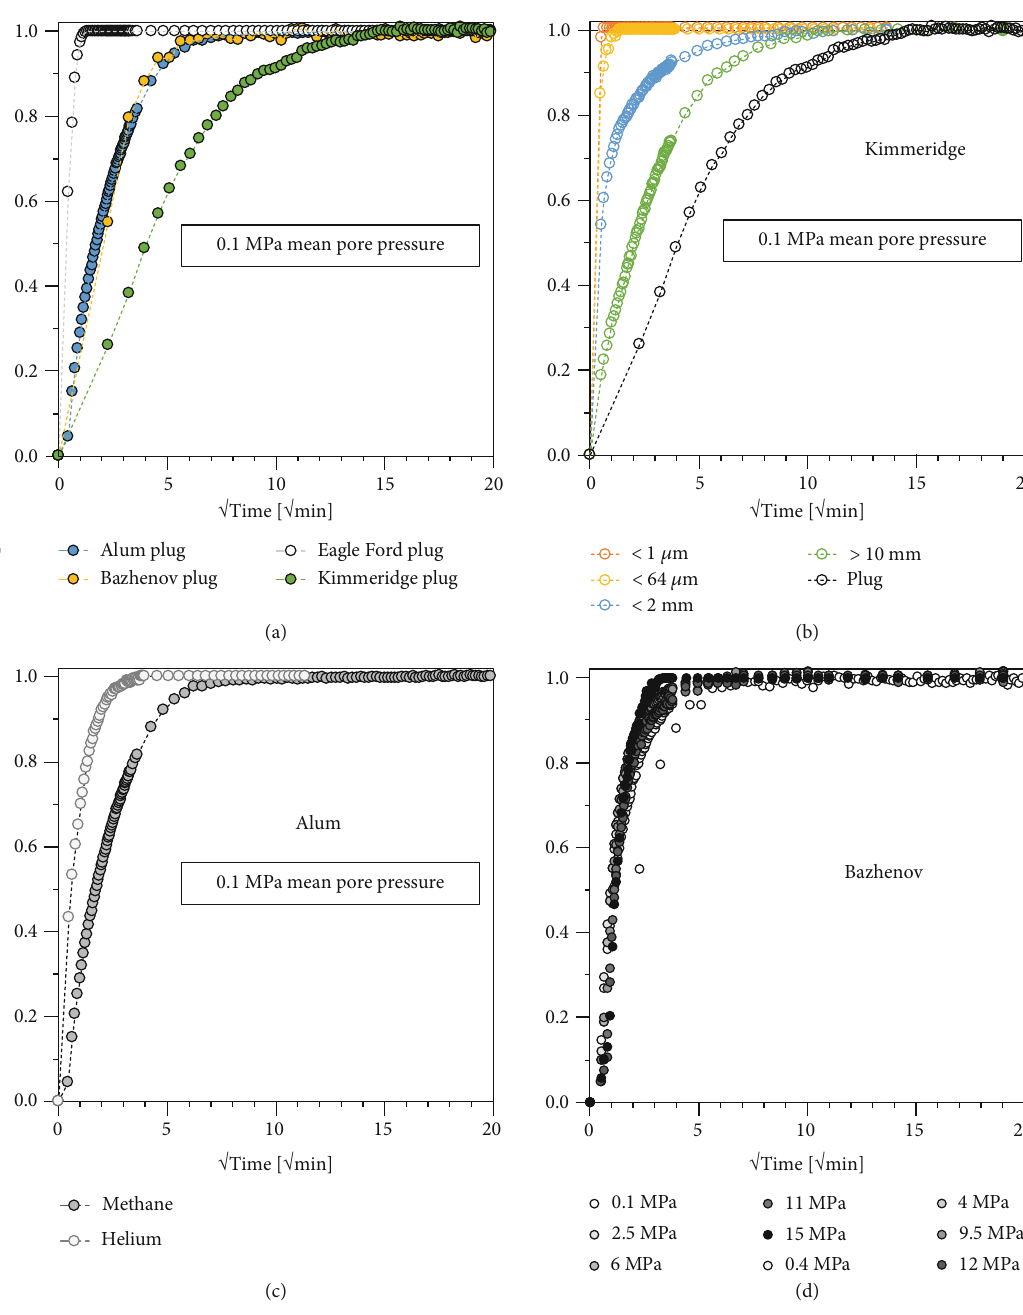
Figure 6: (a) Comparison of fractional methane uptake for all samples investigated in this study at constant mean pore pressure, (b) fractional methane uptake for Kimmeridge Clay at constant mean pore pressure and varying particle sizes, (c) comparison of helium and methane uptakes for the Alum Shale at constant mean pore pressures, and (d) fractional methane uptake with increasing mean pore pressure for the Bazhenov